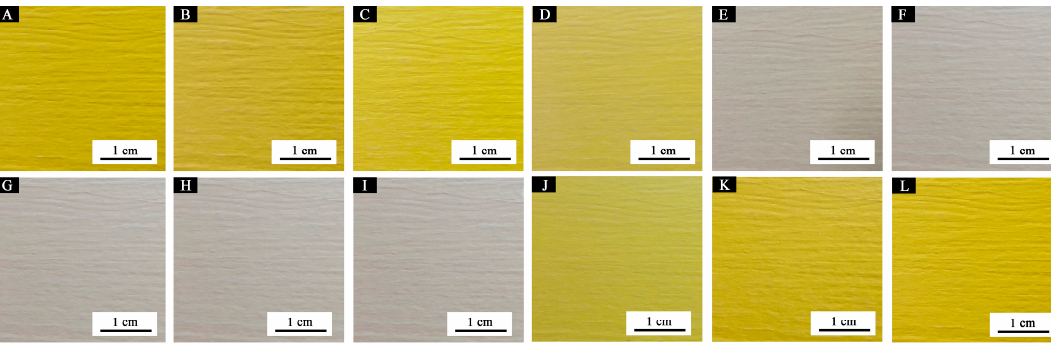
Figure 12. Color trend of primer film containing 15.0% microcapsules: temperature increases to ( A ) 16 °C; ( B ) 26 °C; ( C ) 28 °C; ( D ) 30 °C; ( E ) 32 °C; ( F ) 40 °C during the heating process; temperature drops to ( G ) 40 °C; ( H ) 32 °C; ( I ) 30 °C; ( J ) 28 °C; ( K ) 26°C; ( L ) 16 °C in the cooling process.